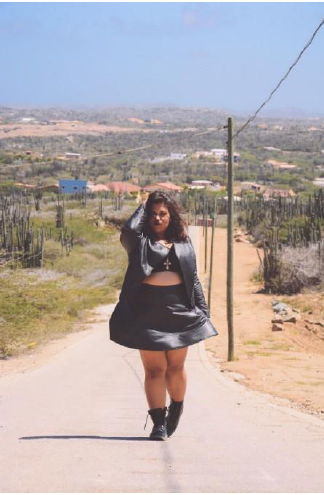
Figure 2. How about feeling freedom within yourself? Photo by: Kevin Wilford Photography (reproduction permission granted). Clothing from Forever21+ and Boots from River Island UK.